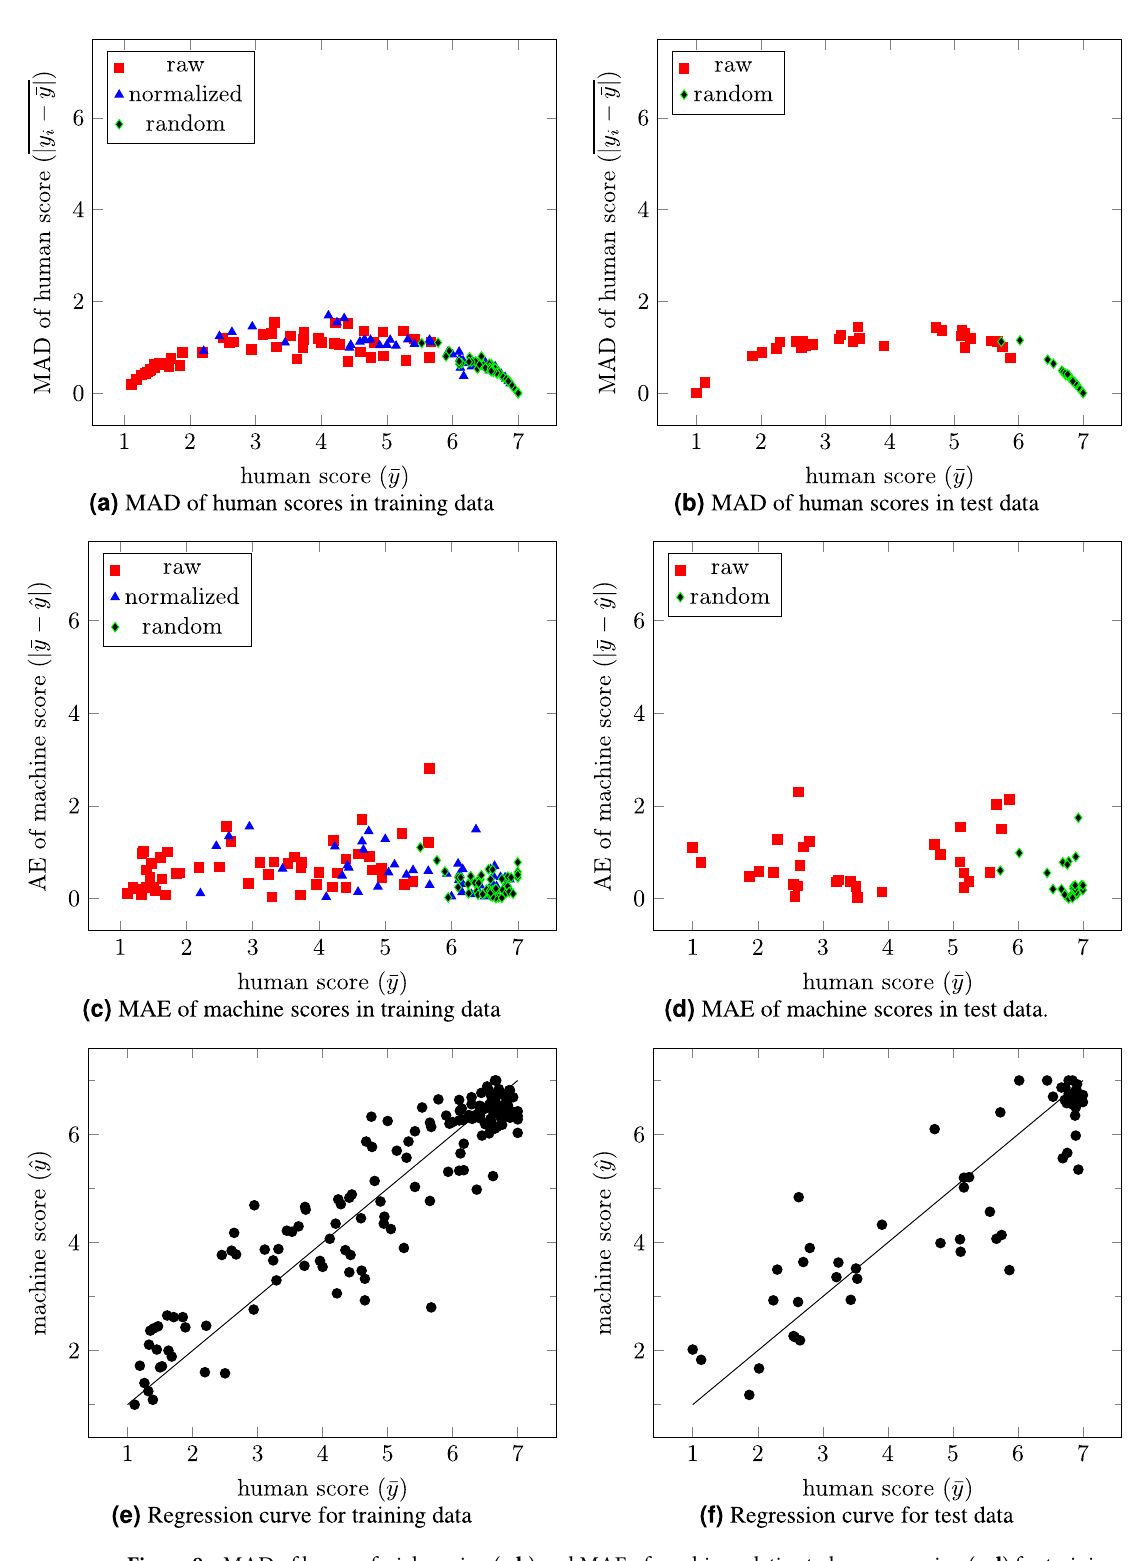
Figure 8. MAD of human facial scoring ( a , b ) and MAE of machine relative to human scoring ( c , d ) for training and test data. Note average deviation from the mean of human scoring increases for scores in the mid range for both training and testing data ( a , b ). On the contrary, machine:human errors are relatively more evenly distributed across the score range. In ( e , f ) the relationship of machine to human facial scoring is illustrated for training and test